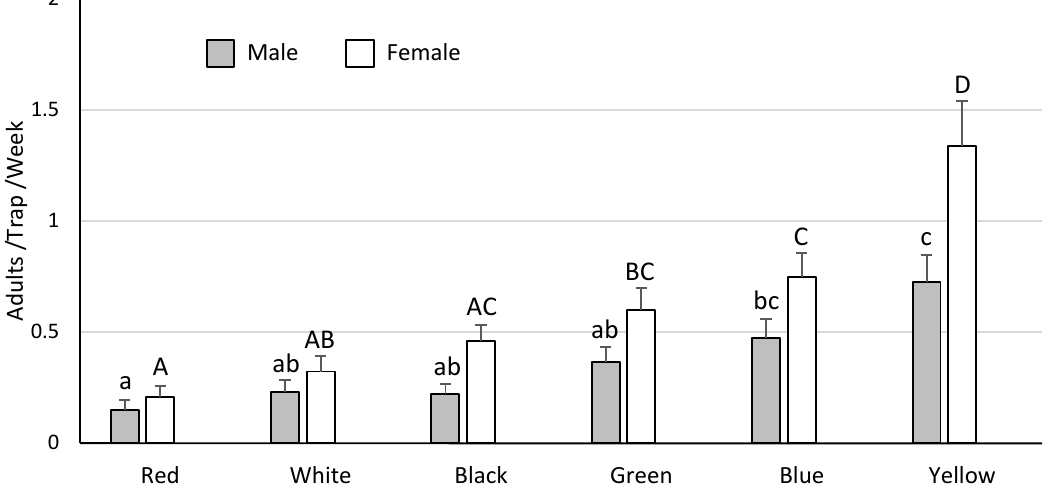
Figure 3. Yellow traps captured the most L. zonatus , followed by blue and green traps. X-axis defines the color of trap evaluated. Columns of the same color without a common letter differ significantly.